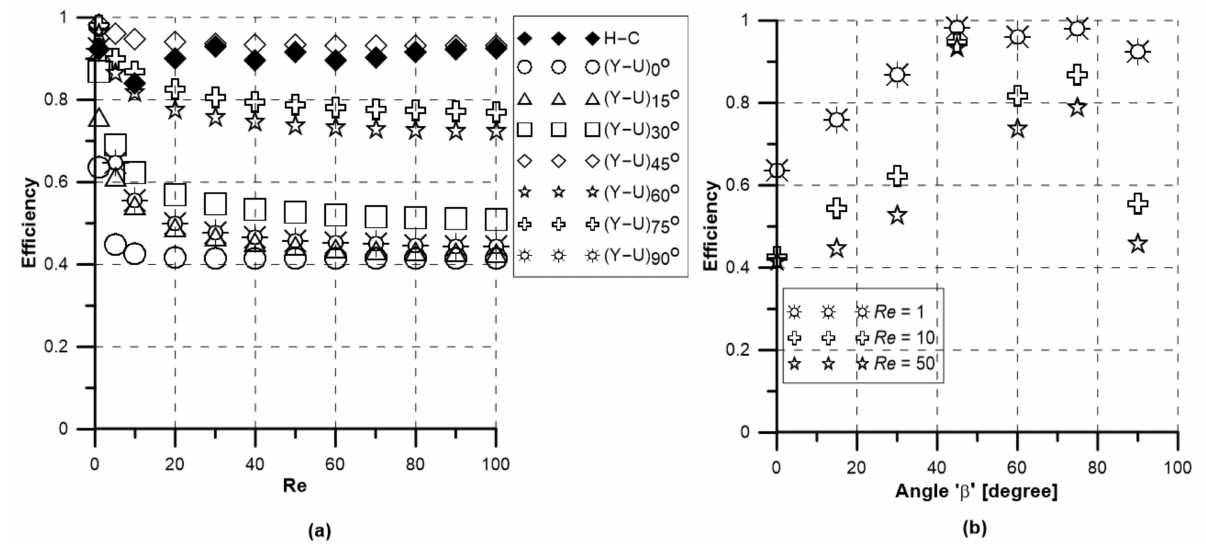
Figure 8. Variation of mixing efficiency with ( a ) the Reynolds numbers ‘ Re ’ and ( b ) the angle ‘ β ’ at the exit.